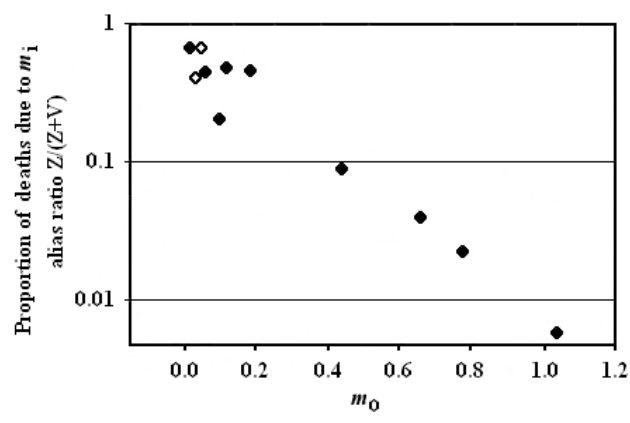
FIGURE 6. Inverse significant correlation (linear regression, r = –0.758708, t = –3.494043, p < 0.01) between m 0 and the proportion of deaths due to m i , or ratio Z/(Z+V). Data are from Ricklefs[2], Table 2 (p. 30). Ricklefs’ Fig. 7 (p. 34) has been redrawn. Ordinates are in logarithmic scale. Open symbols refer to mammal species, solid symbols to bird species.